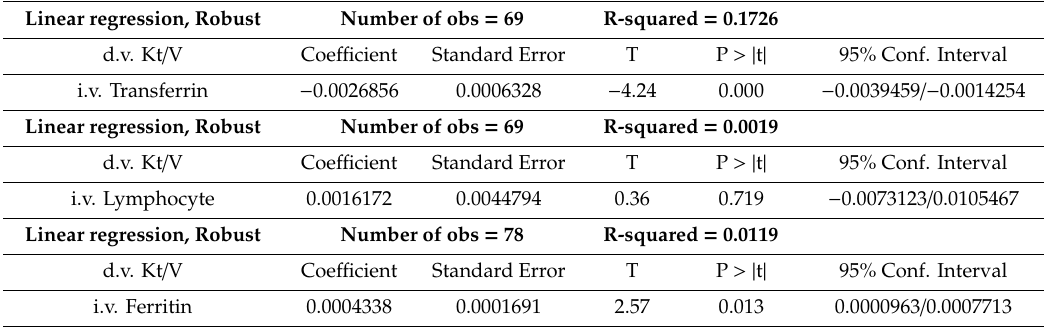
Table 6. Prediction of haemodialysis adequacy by parameters of MICS and iron status. Linear regression,